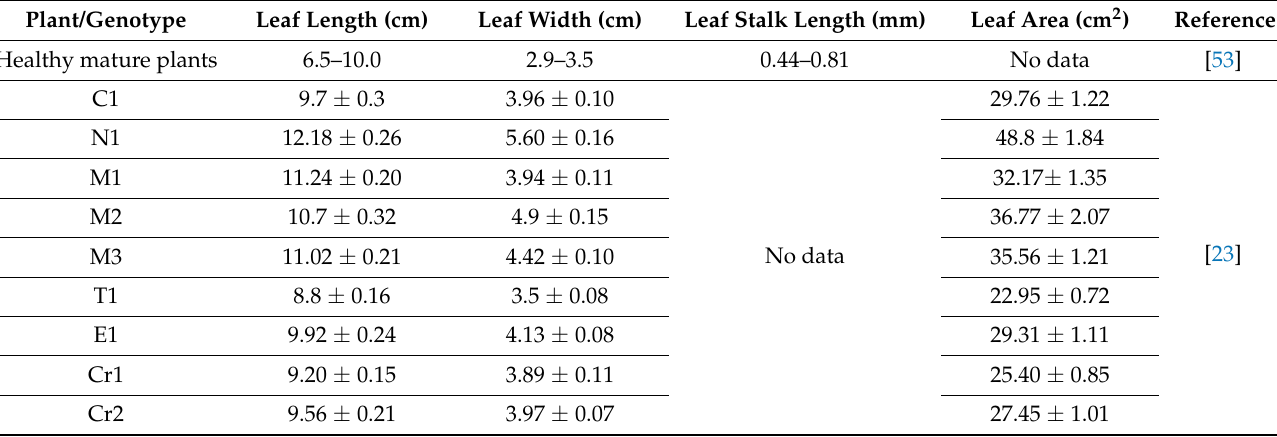
Table 2. Physico-chemical characteristics of medlar